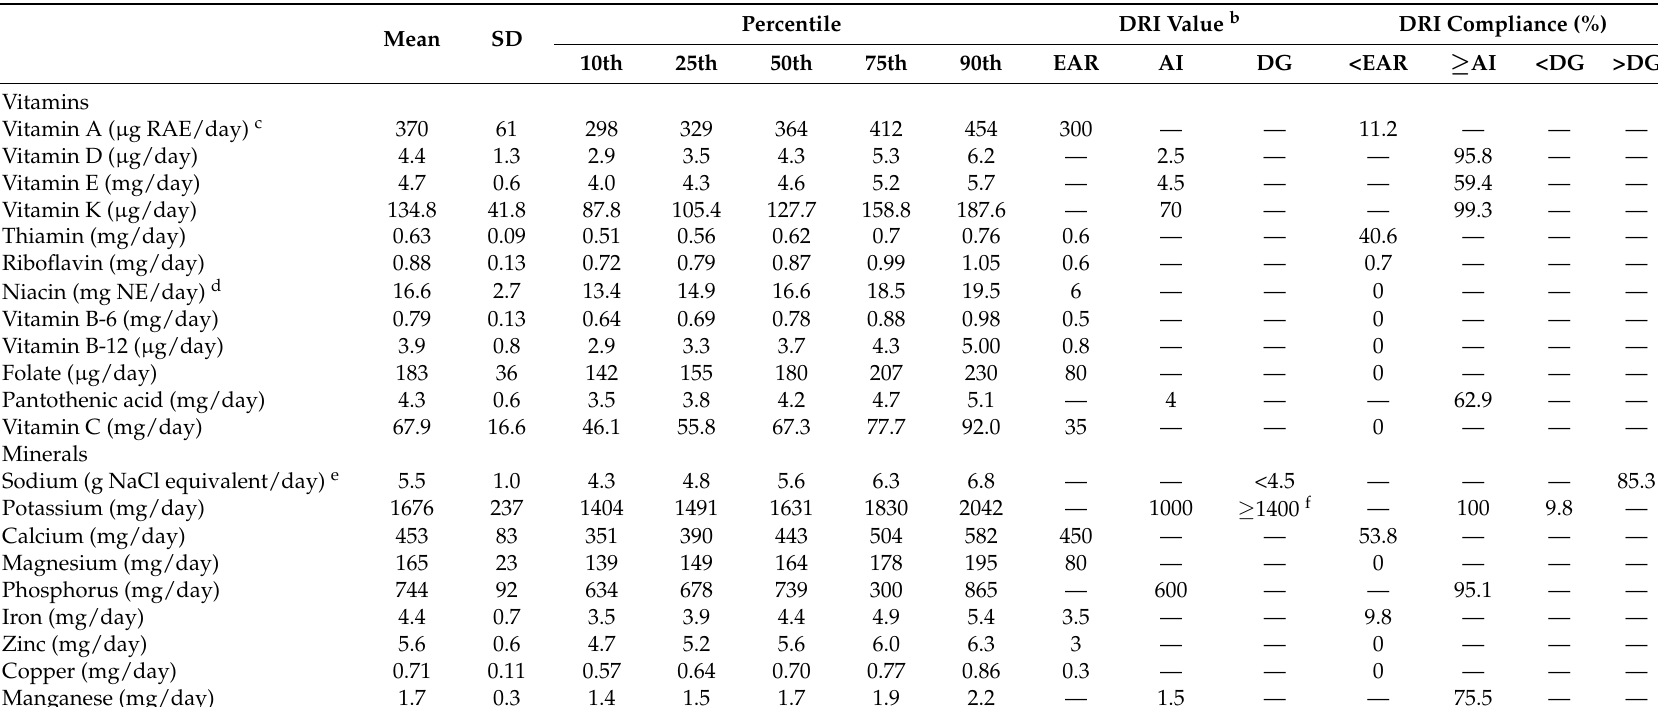
Table 5. Usual intakes of vitamins and minerals from foods and beverages for Japanese girls aged 3–5 years ( n = 143) a